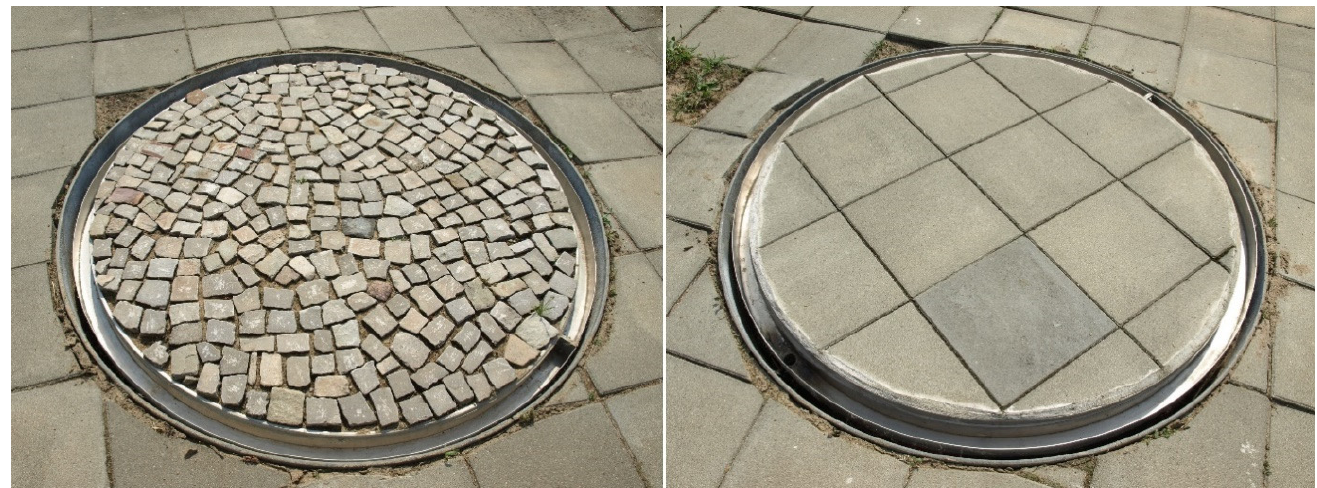
Figure 1. Lysimeter surfaces: ( left ), cobble-stones; ( right ), concrete slabs. Reprinted with permission from Timm [22].